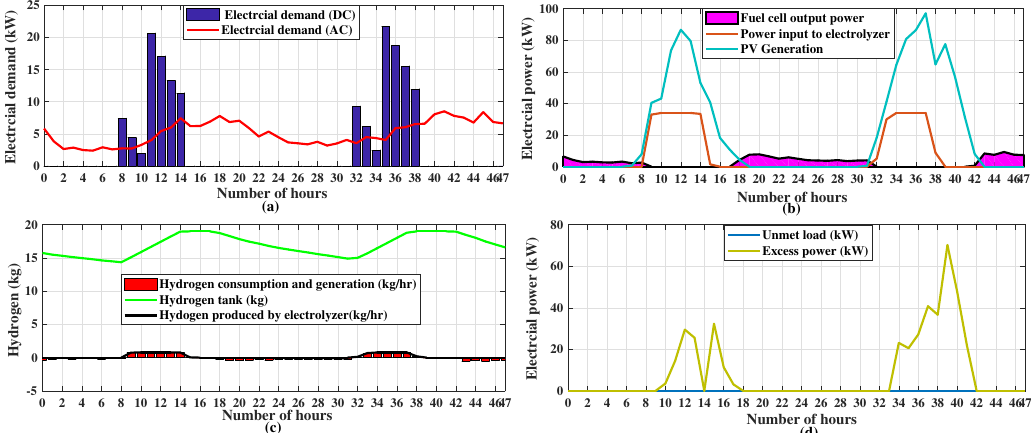
Figure 8. (a) Electrical load demand AC and DC both; ( b ) PV, fuel cell output and electrolyzer input power; ( c ) hydrogen balance; ( d ) excess power and unmet